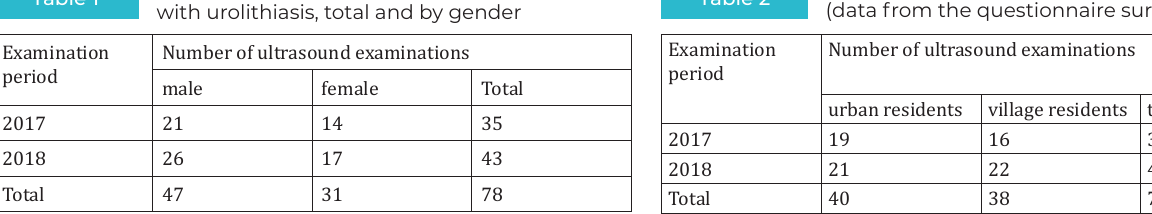
Geographic characteristics of the respondents (data from the questionnaire survey)